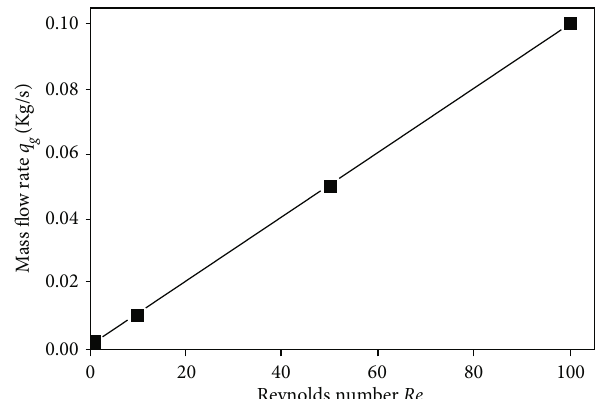
Figure 3: Meshes of numerical models.